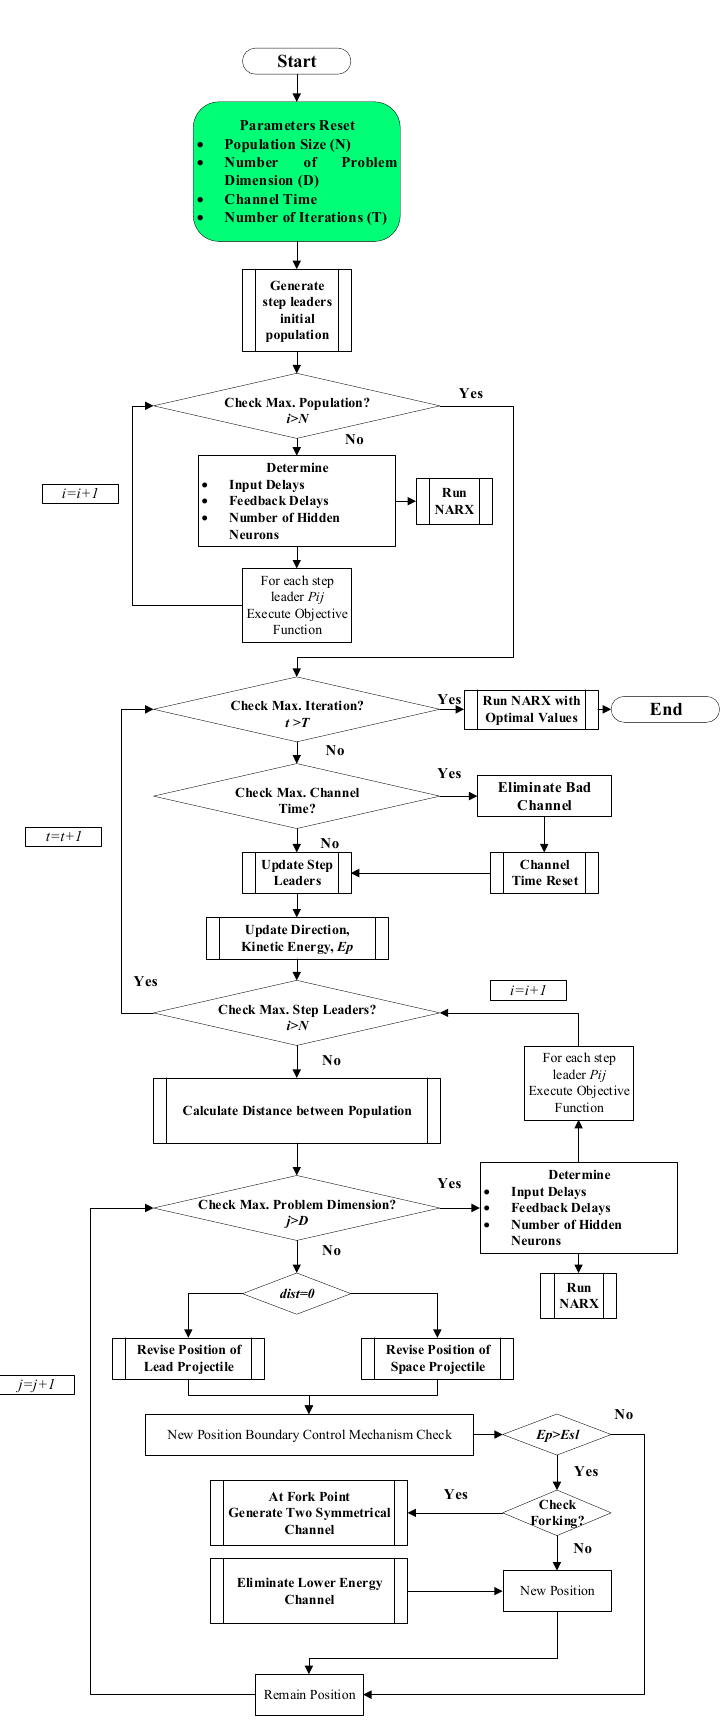
Figure 8. NARX-LSA flow chart.